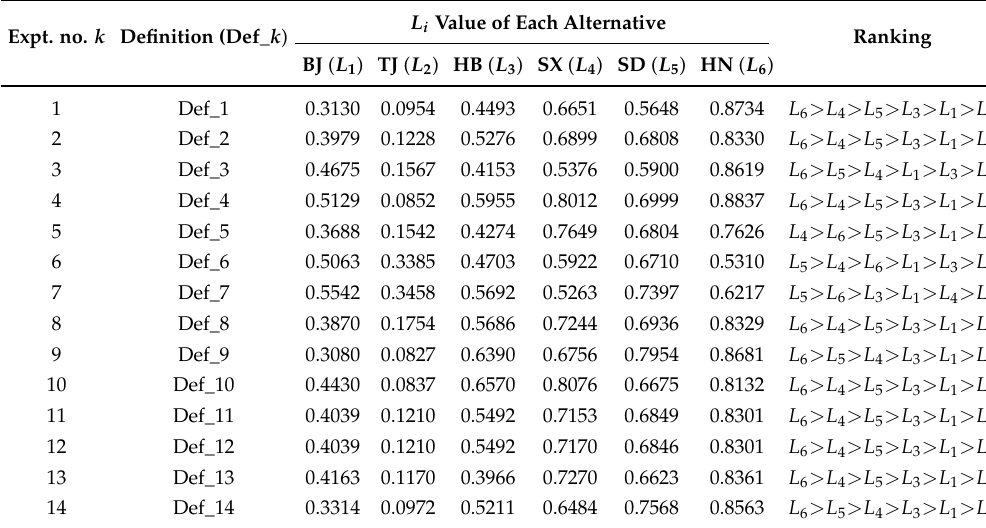
Table 8. Experiments for sensitivity analysis.